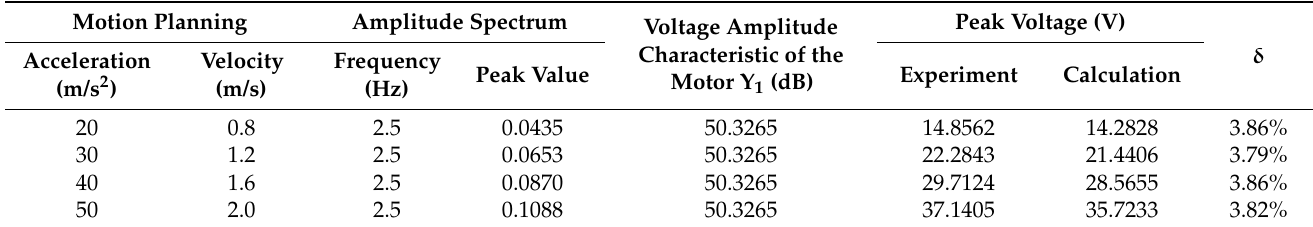
Table 1. Comparison of calculated theoretical and experimental peak